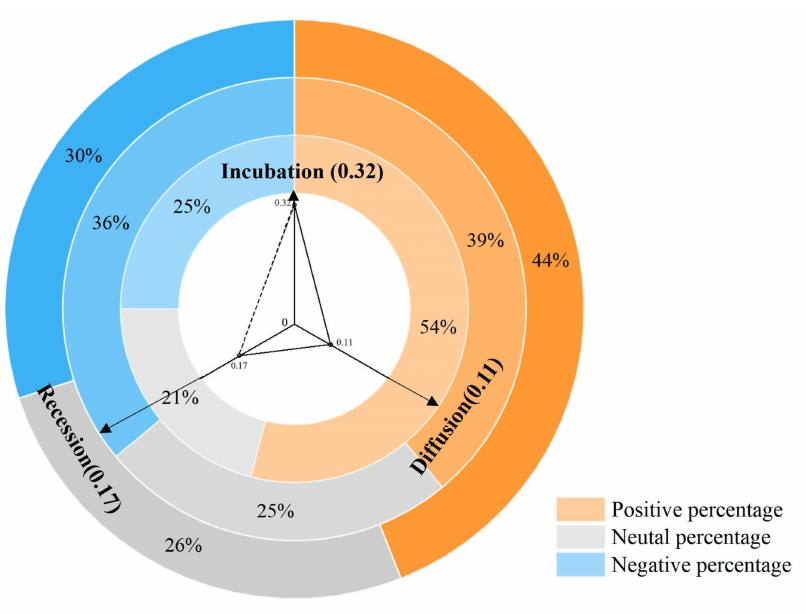
Figure 4. Percentage of emotional polarity and the average sentiment value by